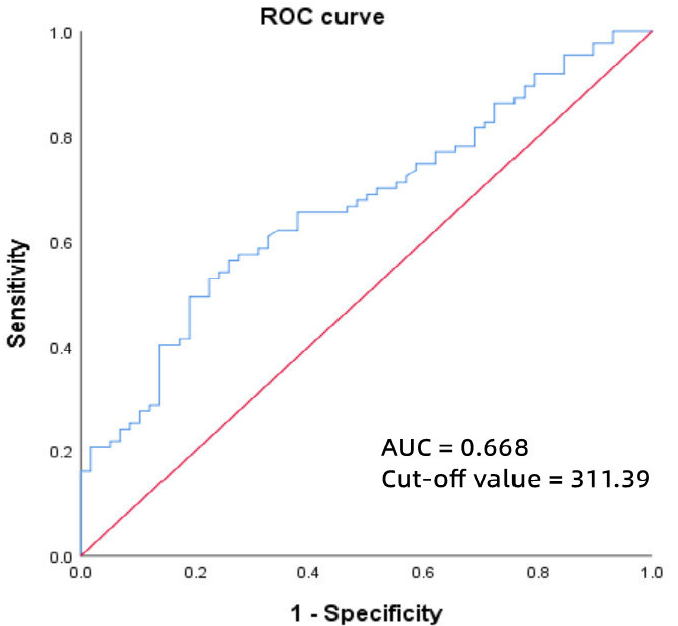
Figure 1. ROC curve of MnSOD for predicting paroxysmal AF. Abbreviations: ROC, receiver operating characteristic; MnSOD, manganese superoxide dismutase; AF, atrial fibrillation.